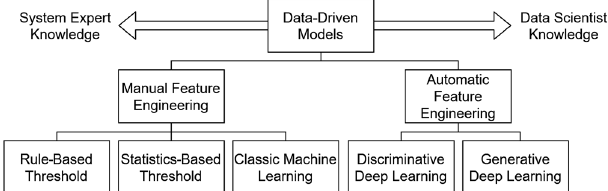
FIG. 7. Overview of different data-driven